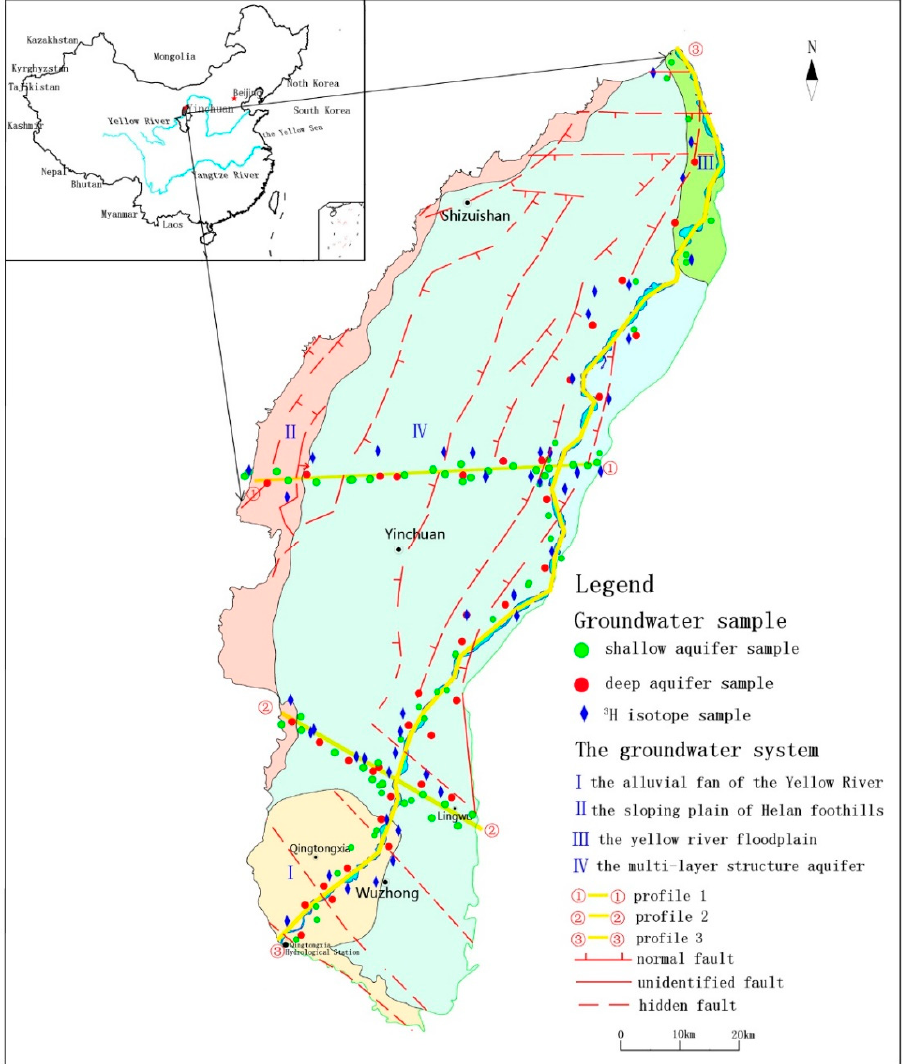
Figure 1. Sketch map of hydrogeology and profiles location in Yinchuan plain.